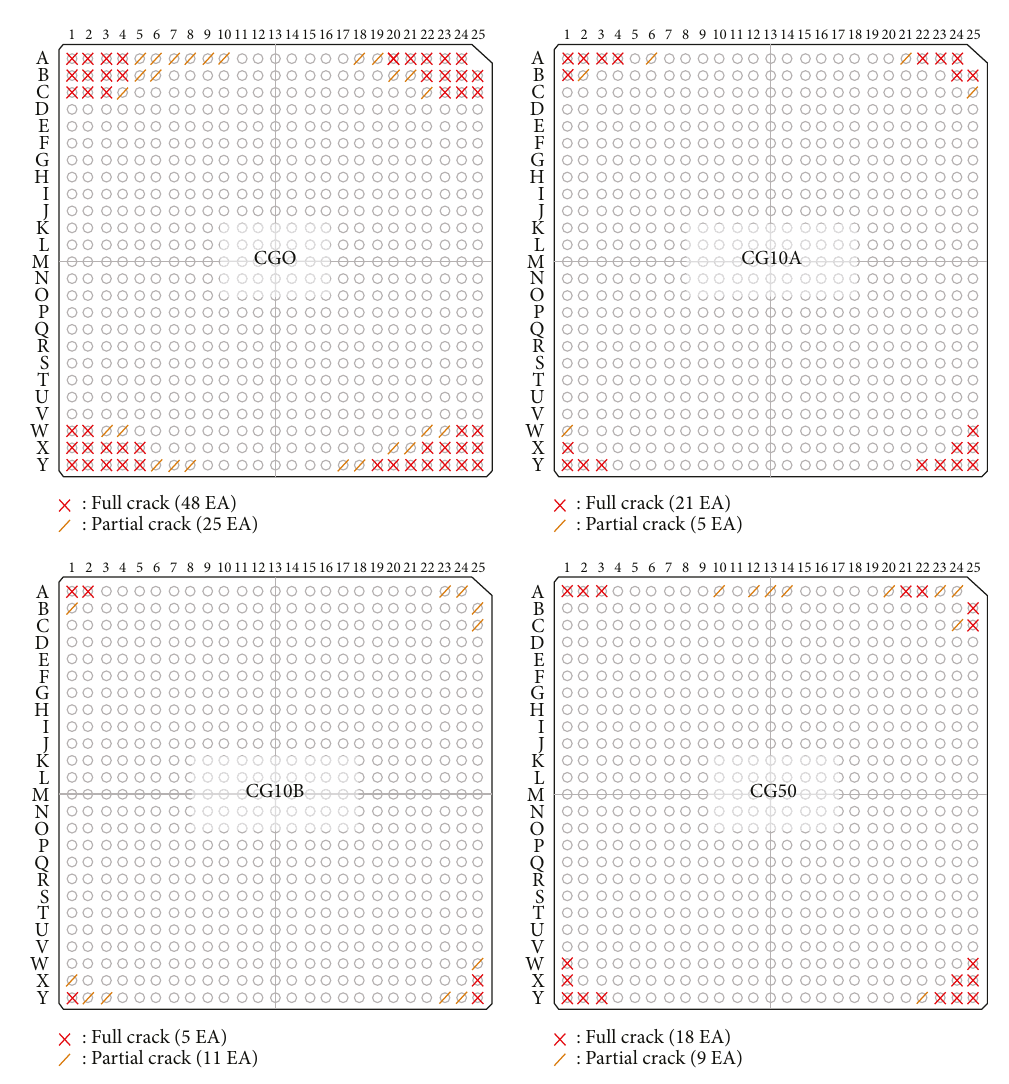
Figure 9: Representative metallographic microscope photographs of the solder joint for CCGA624 package ((a) Full crack, (b) Partial